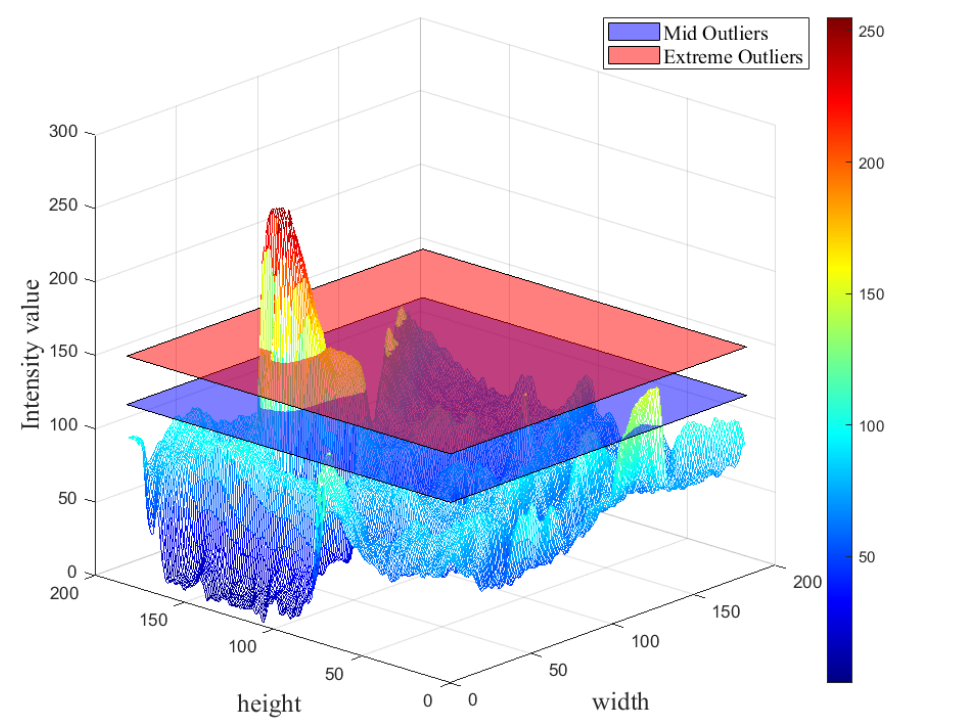
Figure 4. Comparison of detected outliers by mid and extreme values in a preprocessed